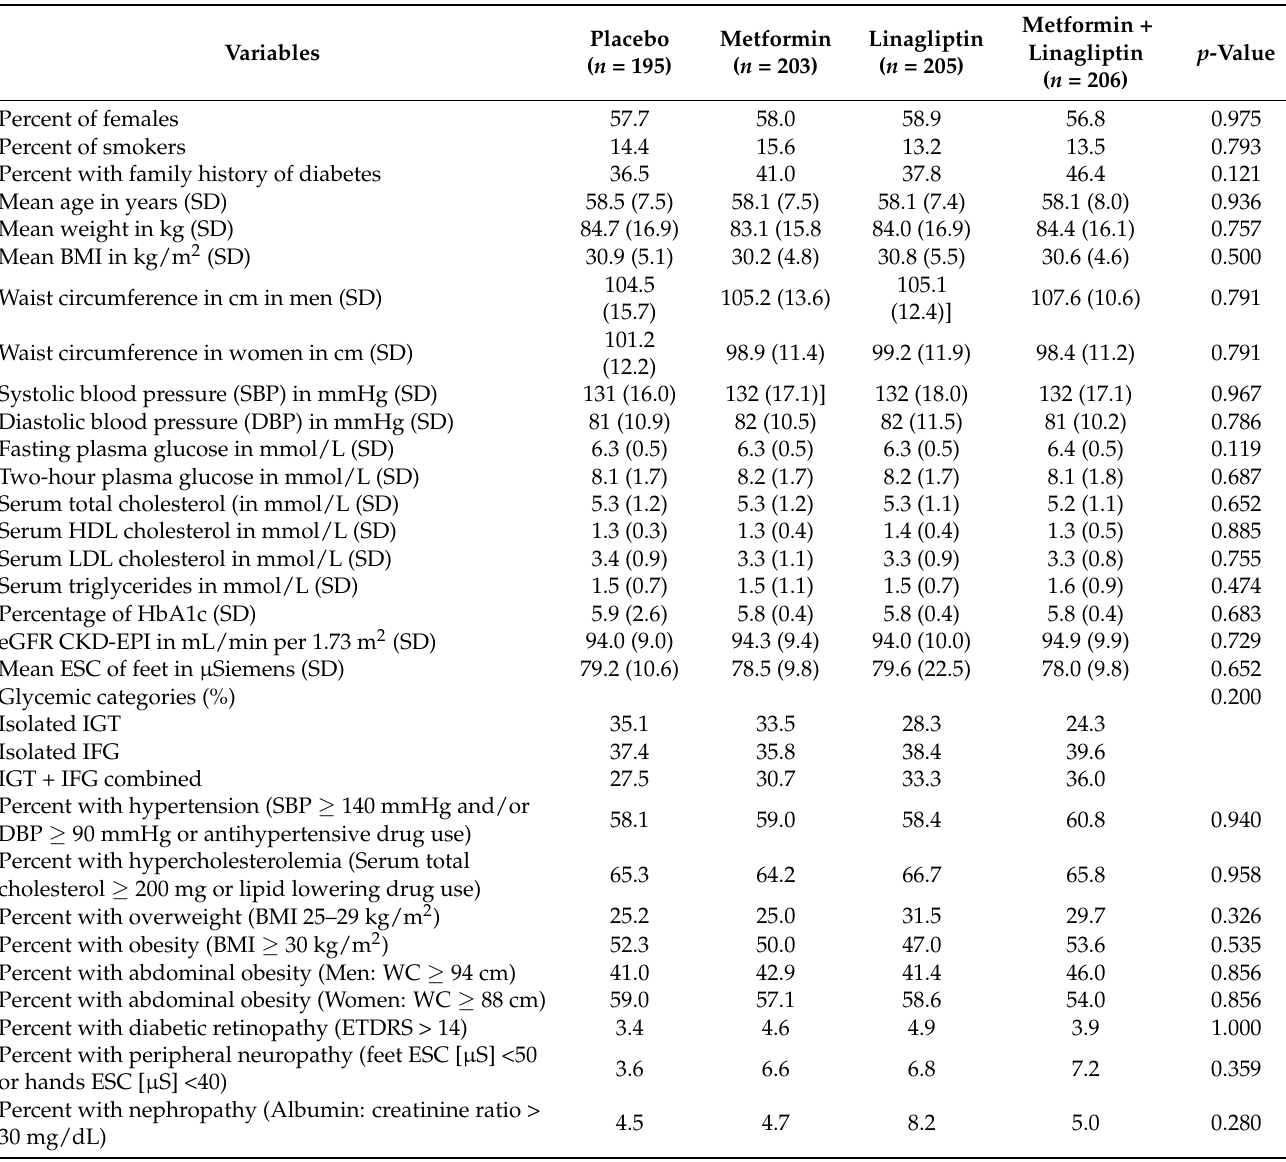
Table 1. Characteristics of participants at baseline examination by study arm ( n =